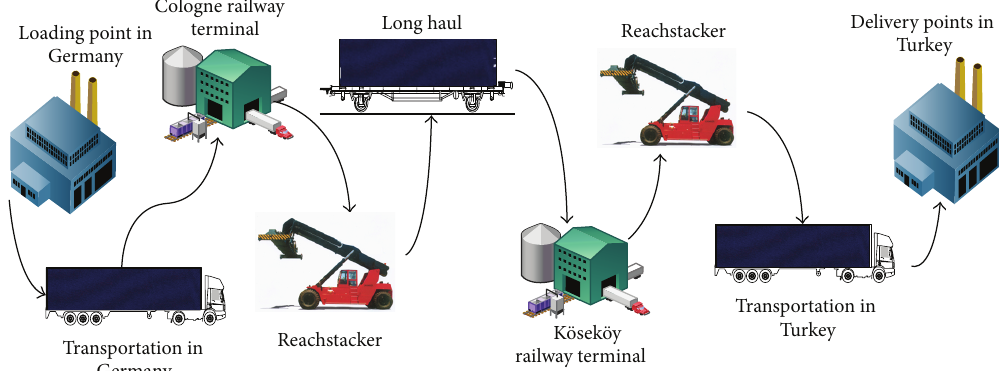
Figure 4: Flow in the current multimodal